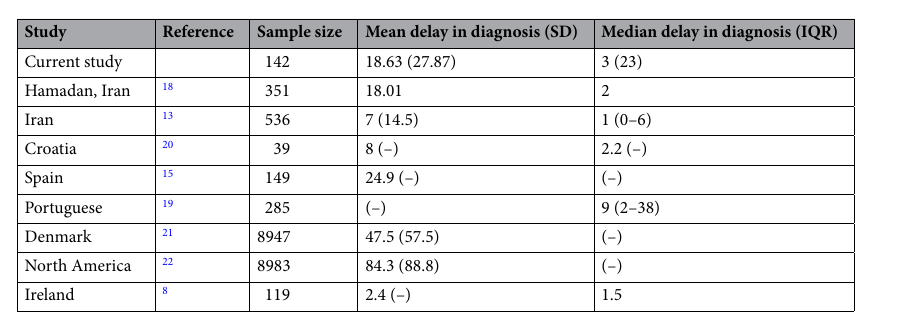
Table 5. Time to diagnosis of MS among Egyptian patients and patients from other countries. The mean (SD) and median (IQR) were reported by